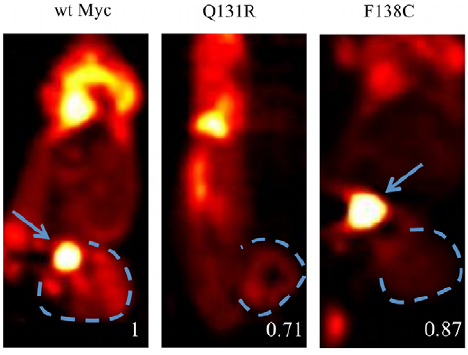
Figure 7. 18 F-2DG imaging by PET. Duplicate tumor-bearing mice inoculated with wtMyc, Q131R, or F138C cells were imaged by PET following injection of 18 F-labeled 2DG. Dotted lines indicate tumor boundaries. Arrows indicate the urinary bladder, where the isotope is expectedly the most concentrated. The average relative SUV is indicated with the value for wtMyc set at 1.